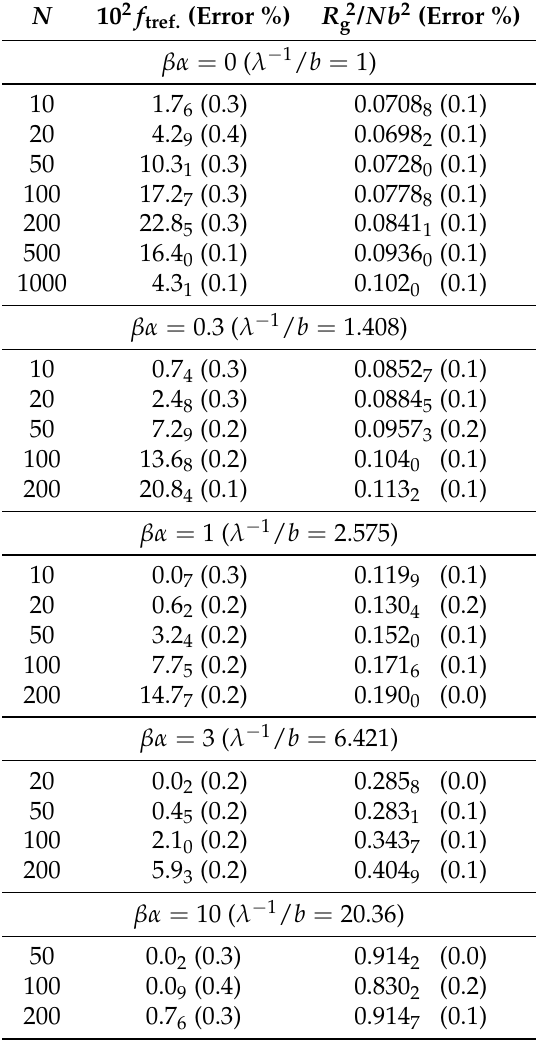
Table 1. Values of f tref. and R 2 g / Nb 2